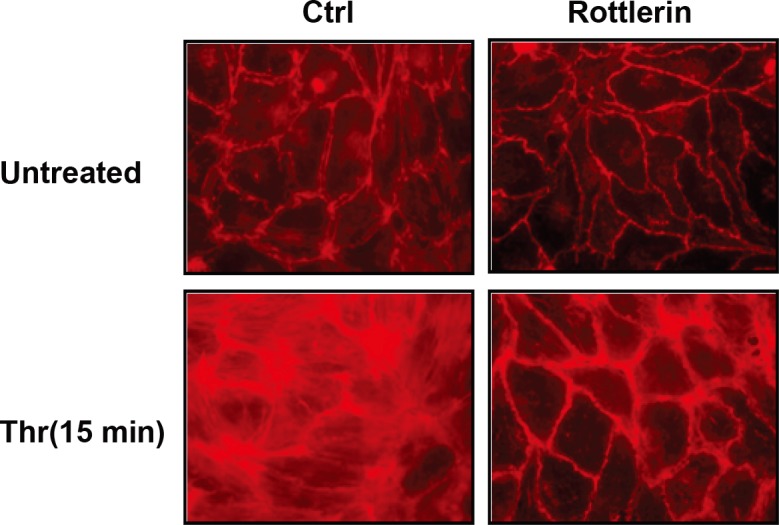
Inhibition of PKCδ abrogates thrombin-induced stress fiber formation.Untreated (top left panel), rottlerin pretreated (10 μ;M, 30 min; top right panel), thrombin treated (bottom left panel), and rottlerin pretreated EC exposed to thrombin (bottom right panel) were fixed, permeabilized, stained for F-actin with Texas-Red phalloidin and imaged by fluorescence microscopy (representative images shown).